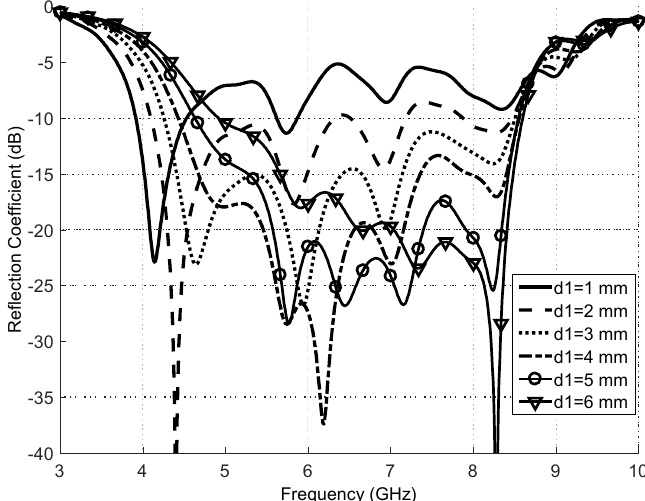
Figure 8. Predicted values of reflection coefficient ( S 11) with varying patch spacing distance, d 1.